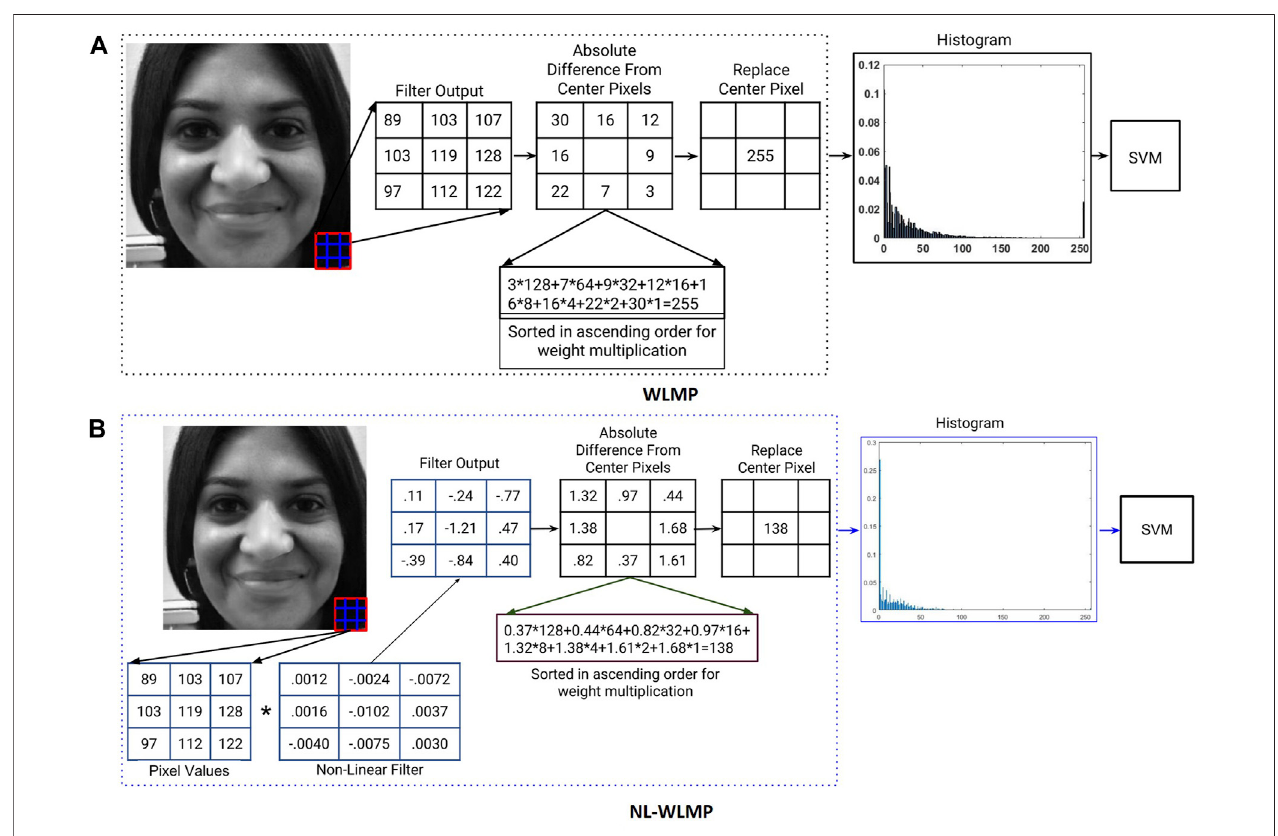
FIGURE 2 | Illustrating the components involved in the proposed Weighted Local Magnitude Pattern (WLMP) and WLMP with convolution of image using non linearly learned fi lters (NL-WLMP) descriptor for digital attack detection.